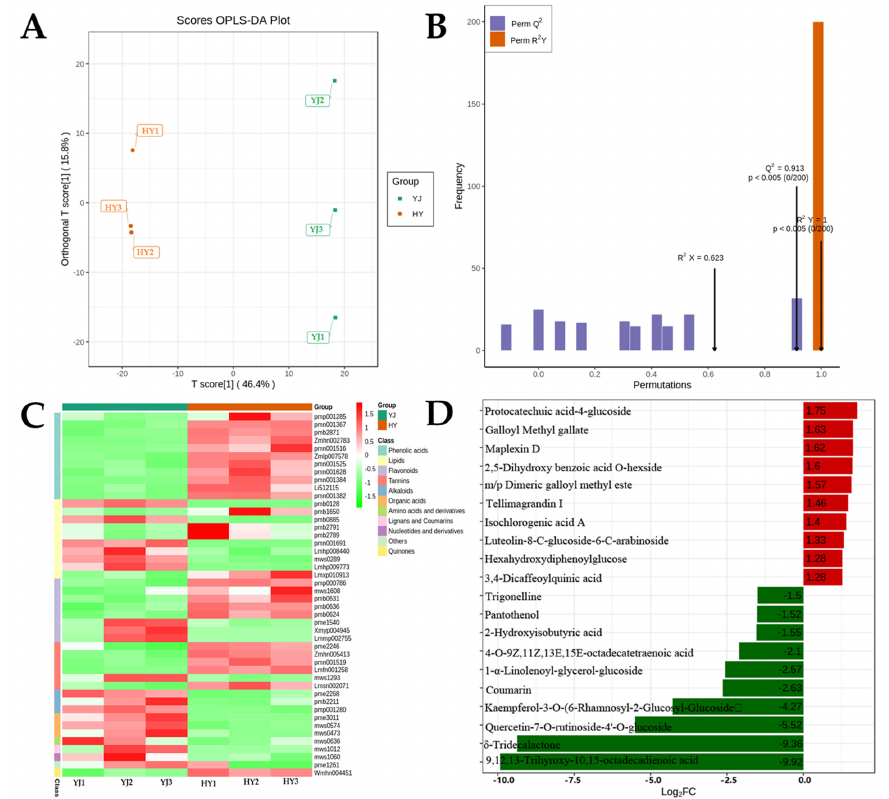
Figure 2. Metabolome quality and differential metabolites analysis: ( A ) OPLS-DA, ( B ) Permutation test for OPLS-DA model, Q 2 > 0.5, R 2 > 0.5, p < 0.005; ( C ) Type of differential metabolites and ex- pression of up-/down-regulation; and ( D ) Differential metabolites of Top 20 FC (fold change of YJ/HY) between ‘Yinghong 9’ (YJ) and ‘Huangyu’ (HY)). YJ was ‘Yinghong 9’ leaves, HY was ‘Huangyu’ leaves. pmn001519, Galloyl Methyl gallate; Lmfn001258, Maplexin D; Zmhn005413, m/p Dimeric galloyl methyl ester; Lmsn002071, Tellimagrandin I; pme2246, Ellagic acid; mws1293, Theaflavin; Wmhn004451, 1,4,8-Trihydroxynaphthalene-1-O-[6 ′ -O-(3 ′ ,4 ′ ,5 ′ - trimethylbenzoyl)] glu- coside; pmn001367, Protocatechuic acid-4-glucoside; pmb2871, 2,5-Dihydroxy benzoic acid O- hexside; pmn001382, Isochlorogenic acid A; pmn001628, Hexahydroxydiphenoylglucose;